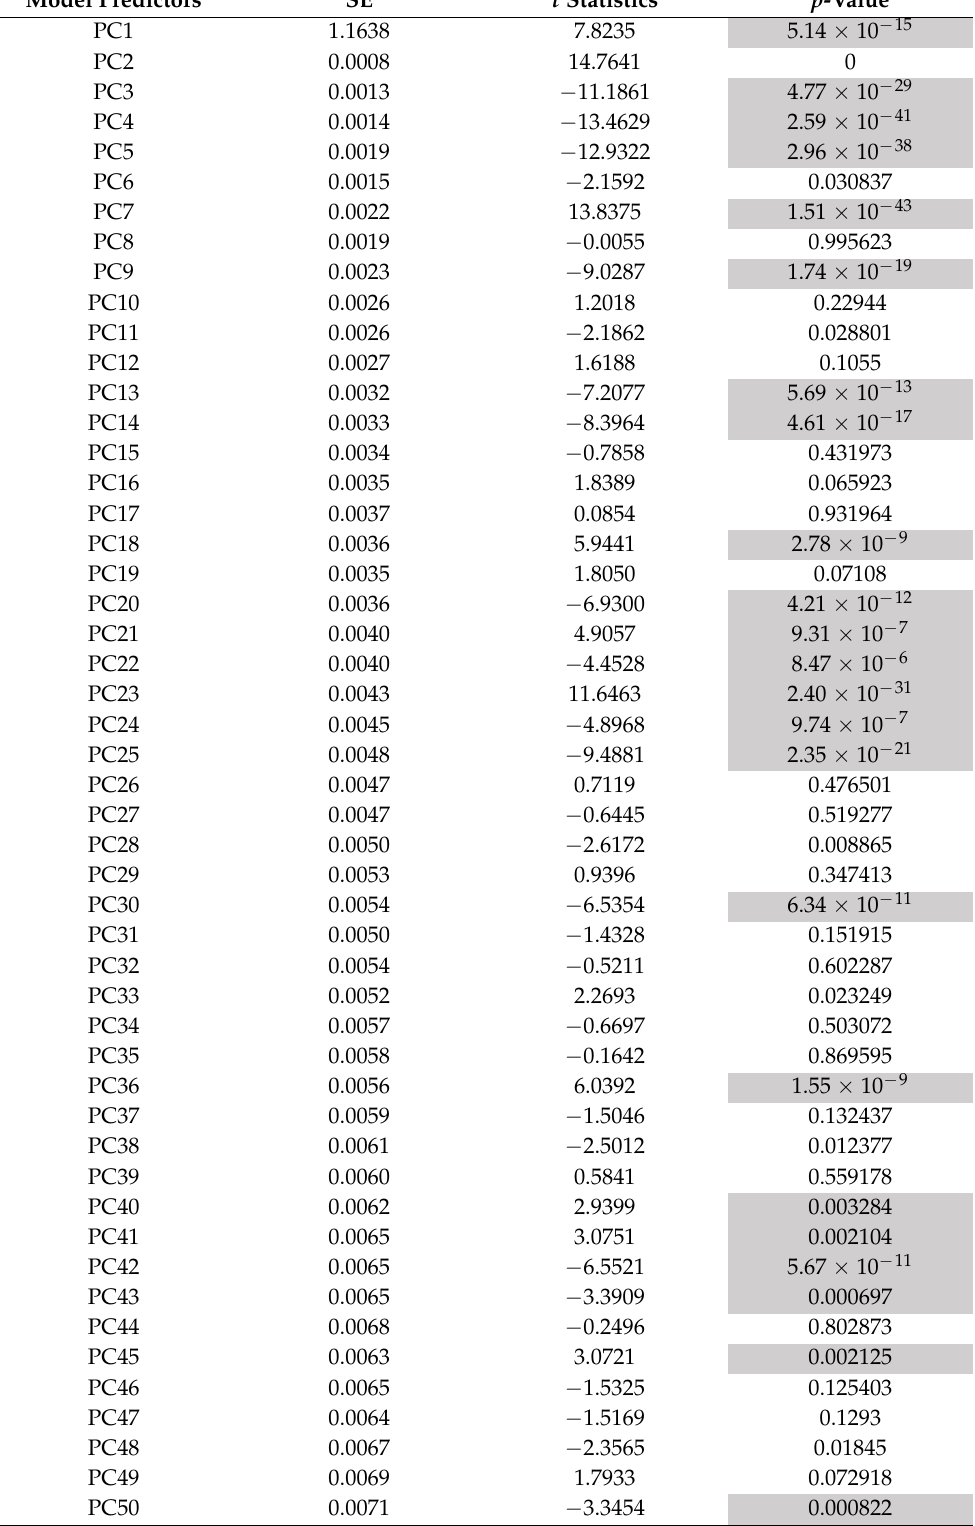
Table 1. Statistics of the Logistic Regression (LR)